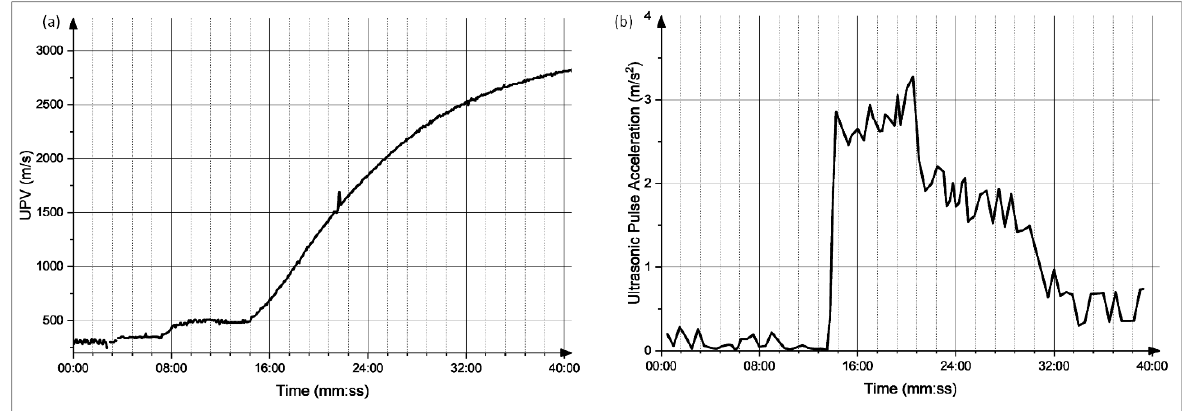
Figure 11. ( a ) Evolution of UPV with time for mix 4. ( b ) Derivative of the UPV graph.